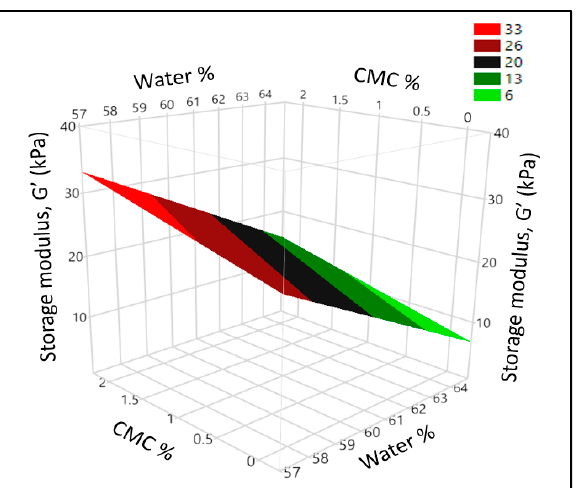
Figure 3. Surface plot showing the effect of water and CMC on the storage modulus (G ′ ) of wheat- cricket flour dough.